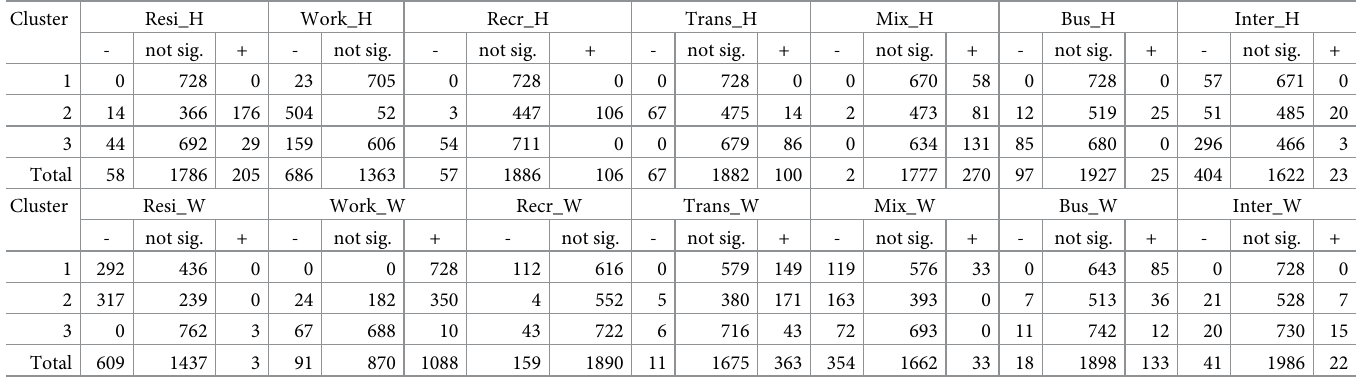
Table 5. Number of predicted variables by clusters.